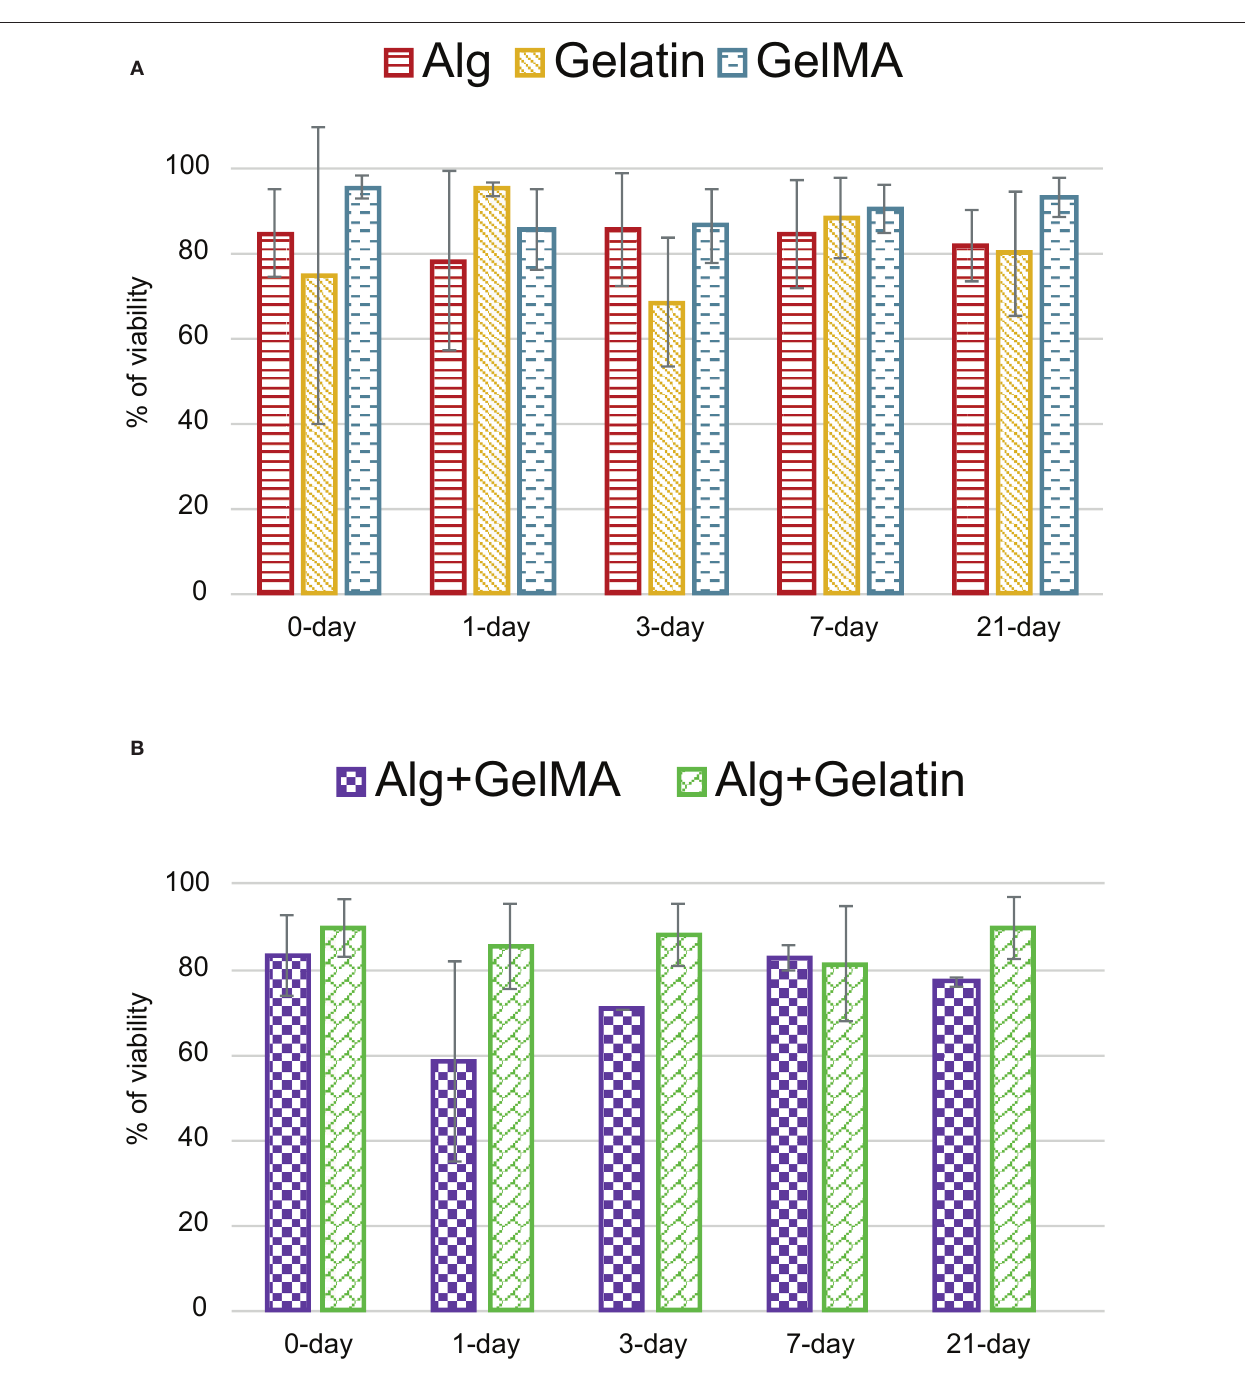
FIGURE 8 | Cell viability for the most important materials: (A) alginate, gelatin and GelMA in the five selected periods, (B) material combinations for selected periods.